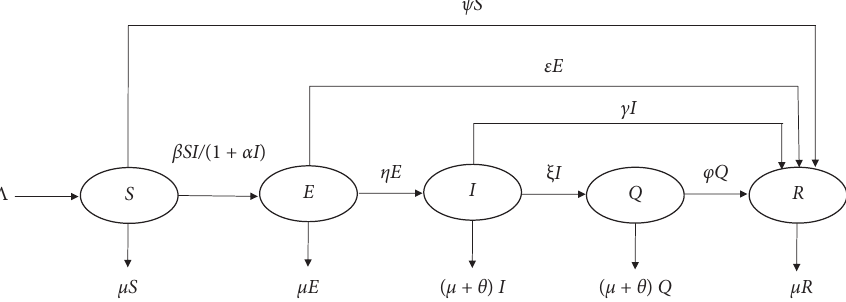
Figure 1: State transition diagram of the SEIQR-type model. Table 1: Explanations and initial values of modeling parameter.